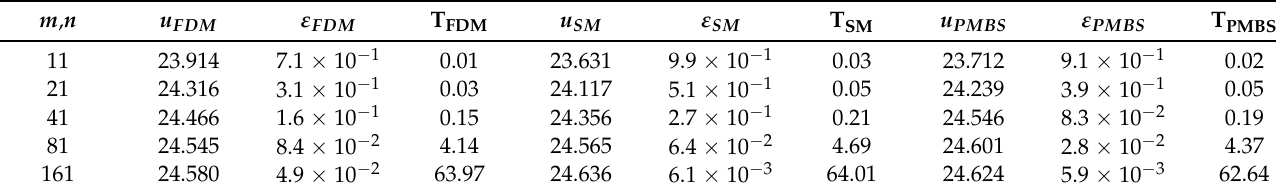
Figure 1. Computational illustrations in Example 1 for PMBS. Top Left : The point plot of the computational solution for m = n = 40. Top Right : The plot of the computational solution for m = n = 40. Bottom Left : The point plot of the computational solution for m = n = 80. Bottom Right : The plot of the computational solution for m = n = 80. Table 2. Convergence history for Example